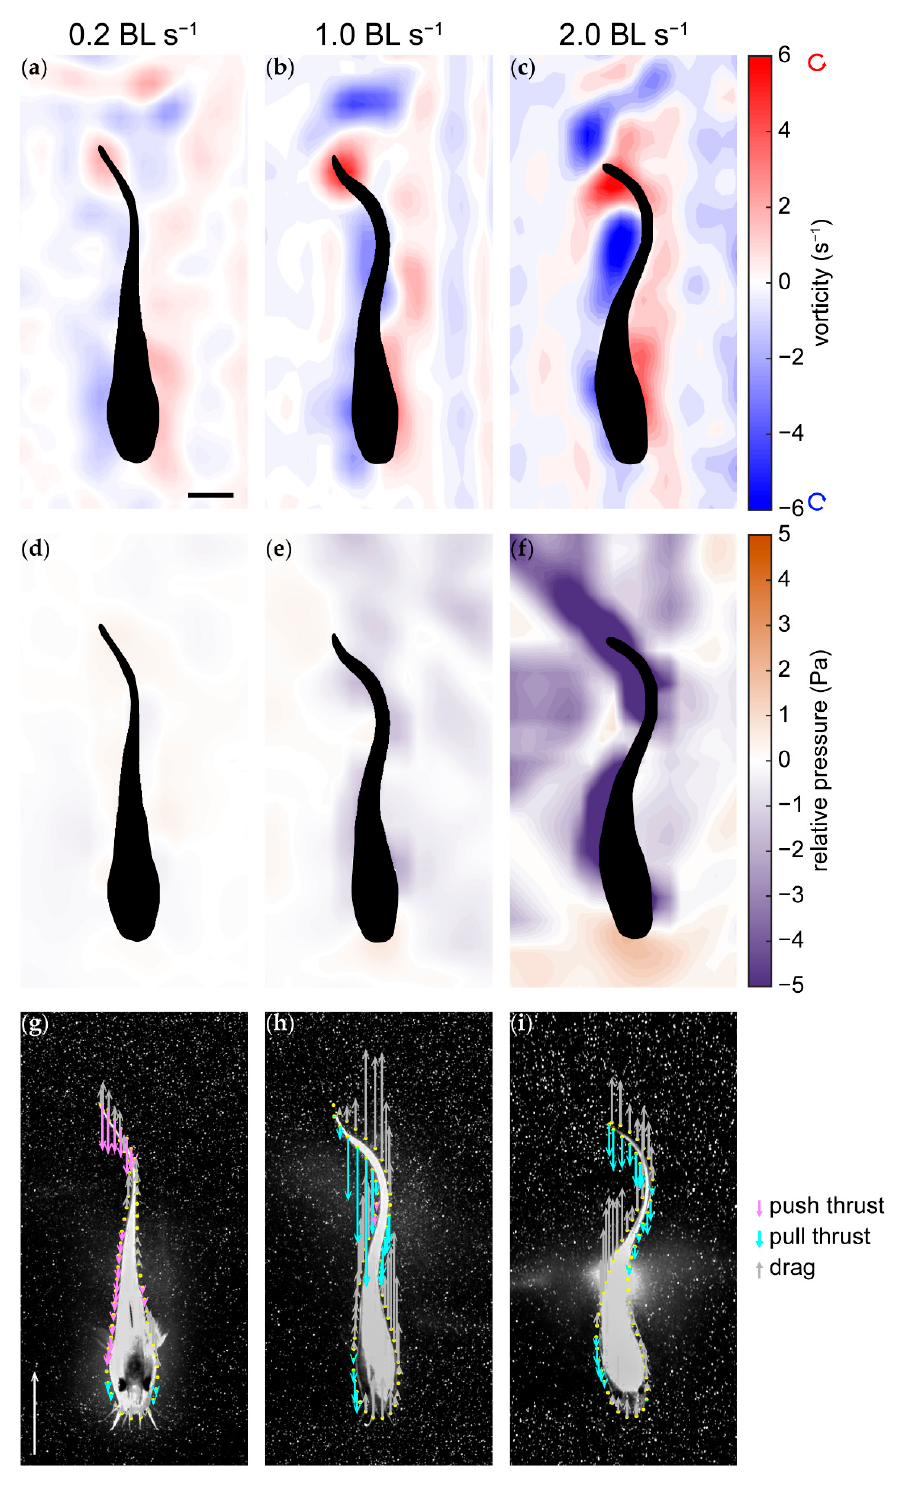
Figure 5. Vorticity, pressure, and force components. Selected frames during steady swimming at 0.2, 1.0, and 2.0 BL s − 1 . ( a – c ) vorticity fields with velocity vectors. The scale arrow indicates 0.5 m s − 1 . ( d – f ) Pressure fields. ( g – i ) Thrust and drag component vectors. The scale arrow indicates 0.01 N m − 1 . The scale bars indicate 10 mm for all frames.